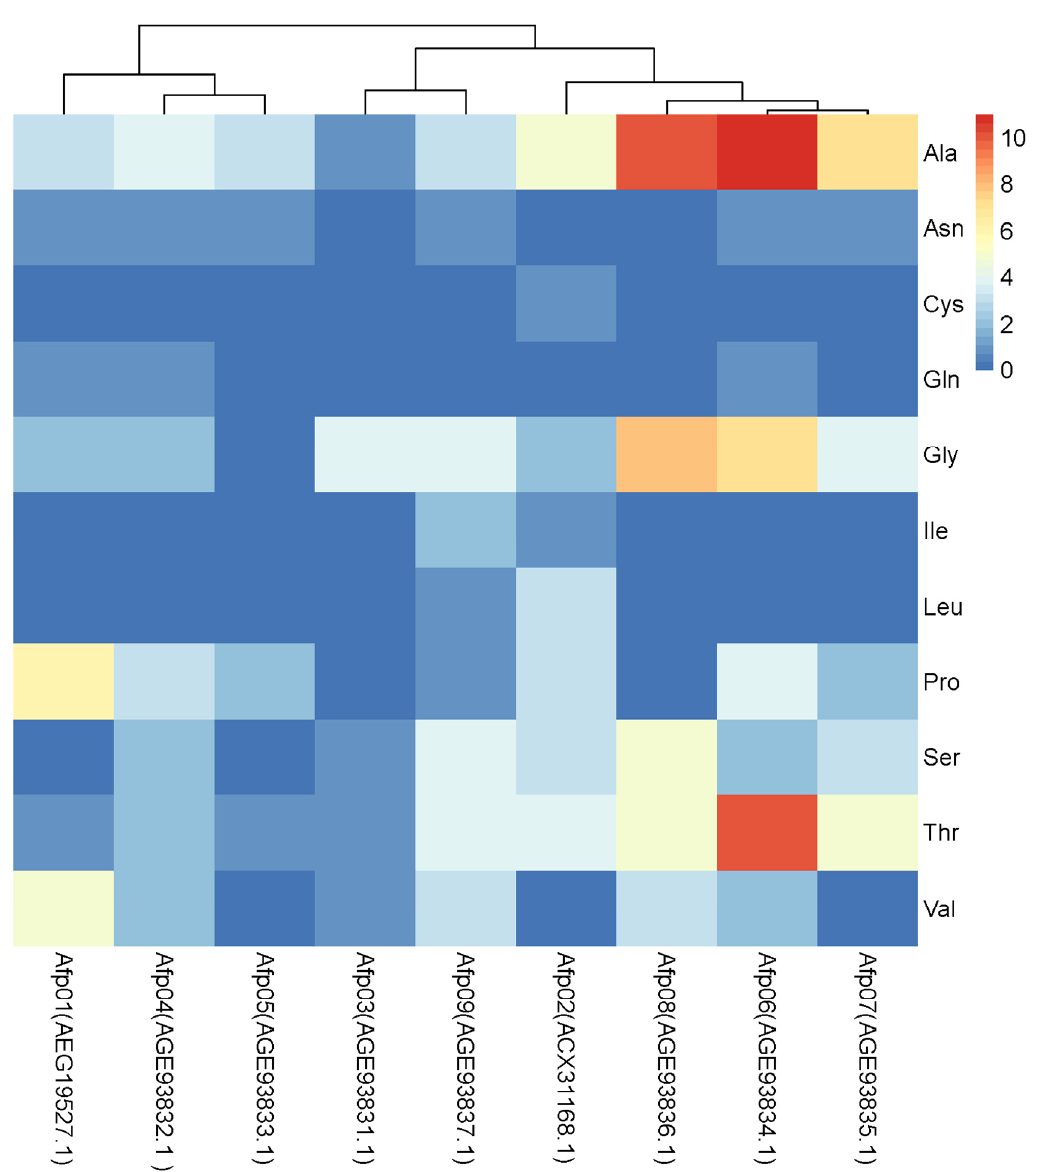
Figure 5. Potential ice-binding sites of different AFPs.